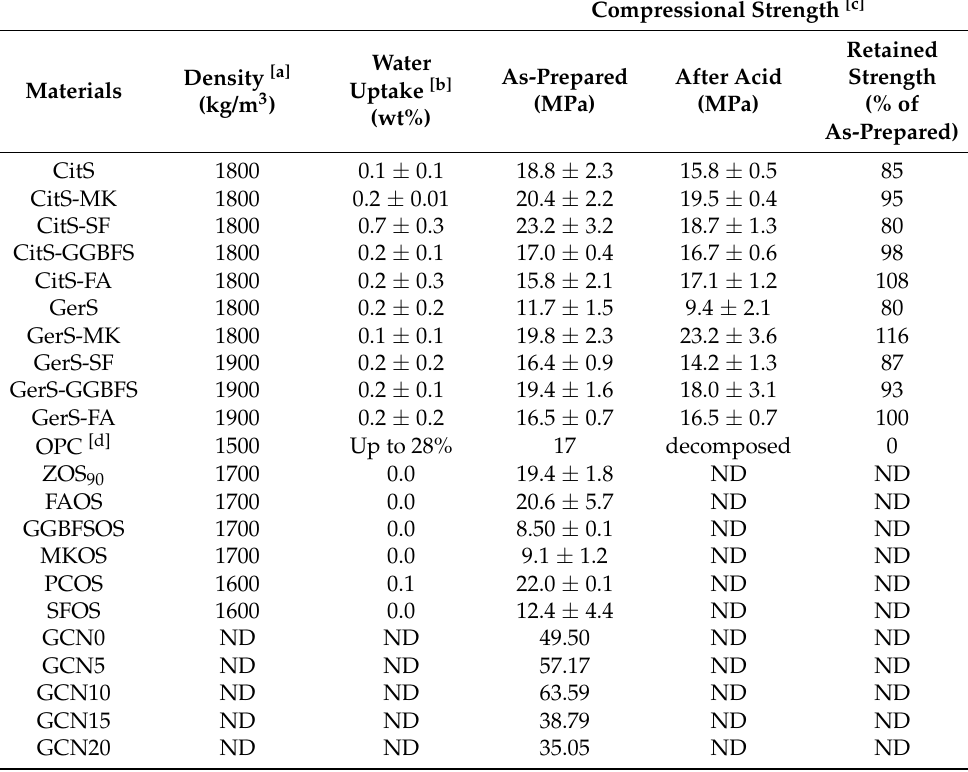
Table 3. Properties of composites and